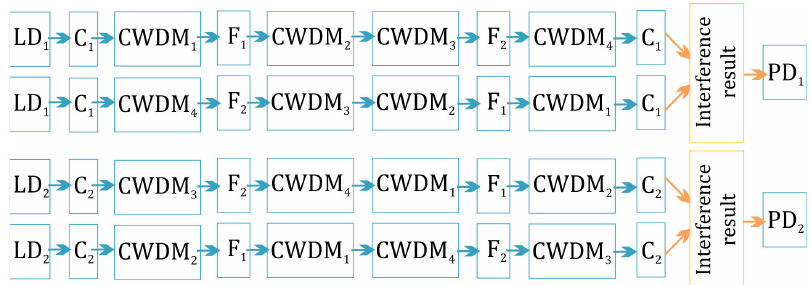
Figure 5. Possible light propagation paths.